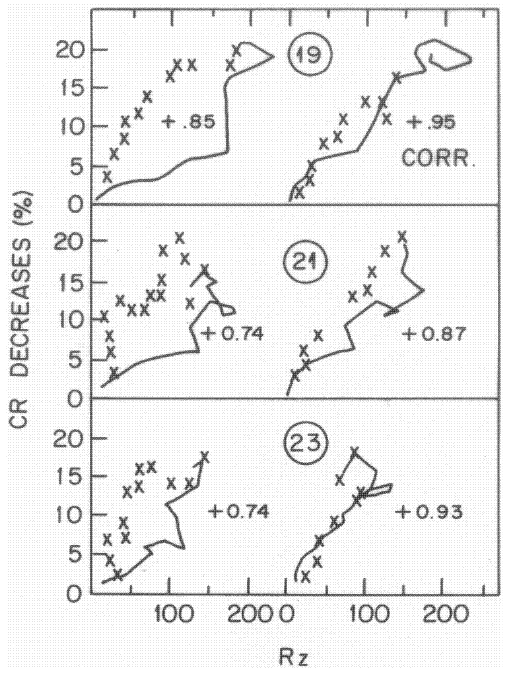
Fig. 4. Hysteresis loops for CR (ordinate in percent) versus Rz , left half, direct data (original loop), right half CR values advanced for the estimated delays. The full lines are for the rising part of the solar cycle and the crosses for the declining